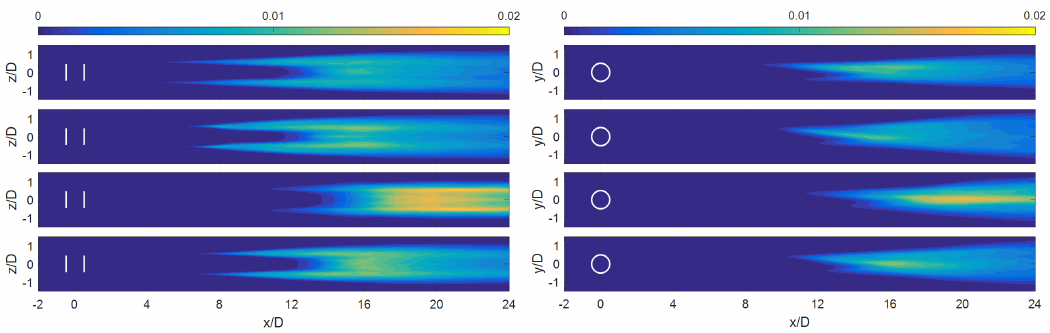
) in the central vertical x − z 0